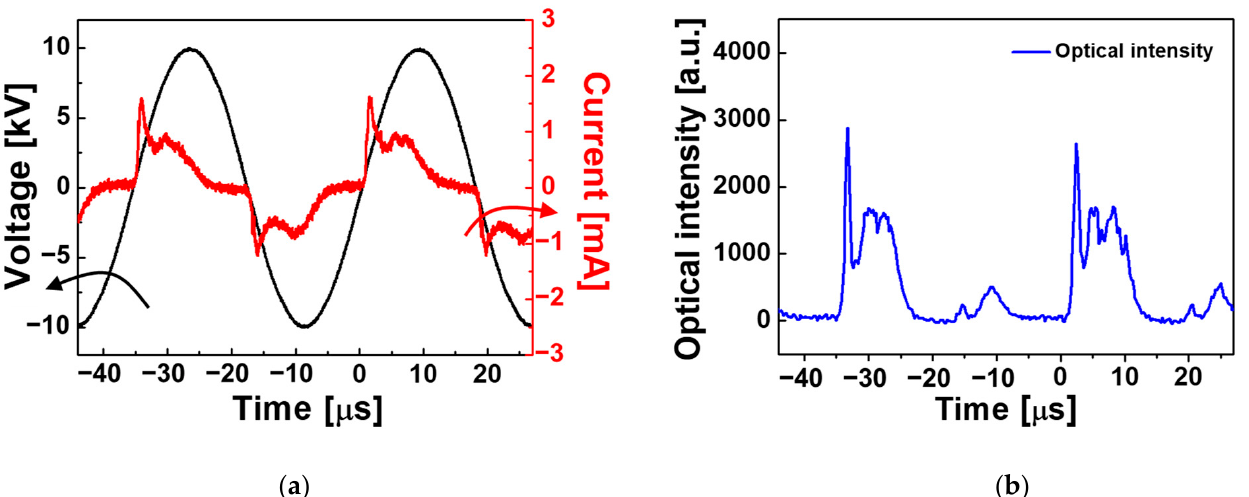
Figure 3. Temporal behaviors of ( a ) driving voltage (black line) and discharge current (red line), and ( b ) optical emission from the plasma generated by the proposed APPJ array.